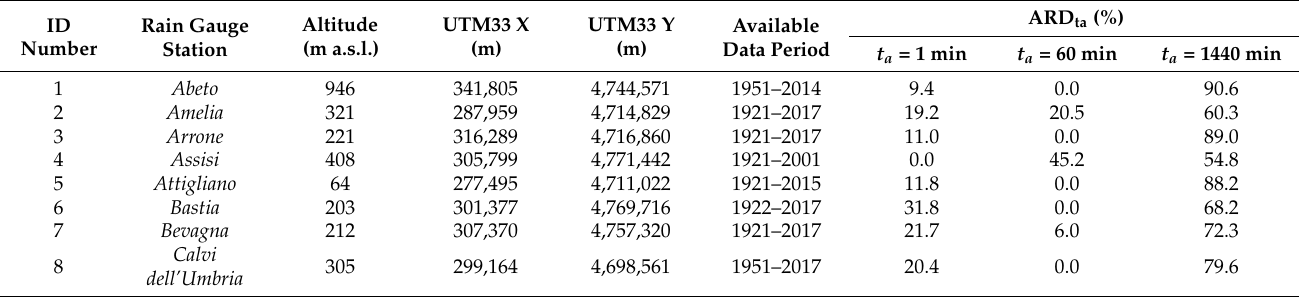
Figure 1. Morphology of the study area and rain gauges used in the analysis with identification numbers listed in Table 1. The background Digital Elevation Model (DEM), whose spatial resolution is 25 m, is derived by the Copernicus EU-DEM v1.1. Table 1. Main characteristics of the selected rainfall stations. The geographic position is expressed in Universal Transvers Mercator (UTM) coordinates computed by using the WGS84 ellipsoid model. ARD ta is the percentage of available rainfall data characterized by specific temporal aggregation, t a